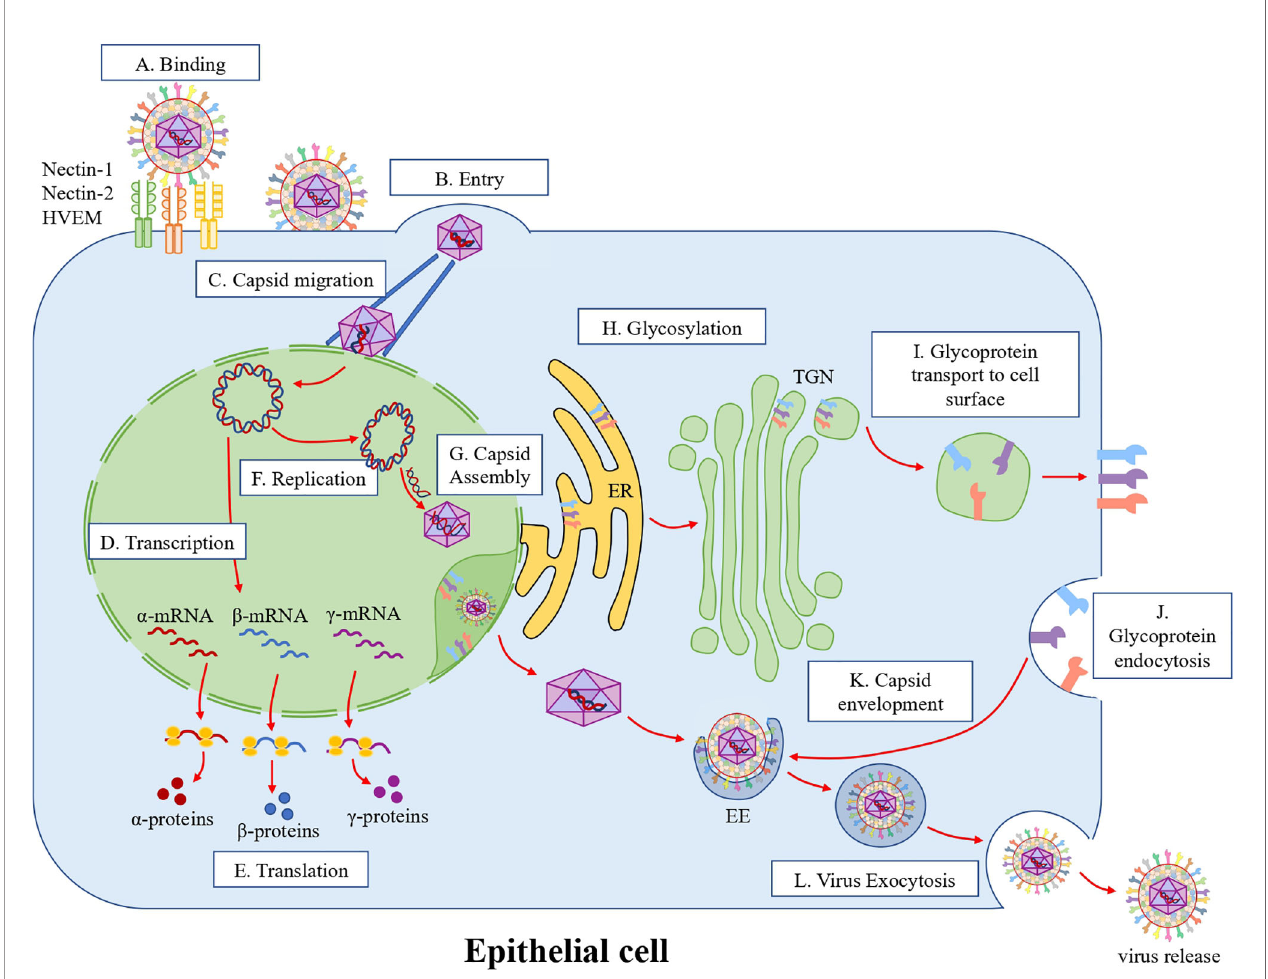
FIGURE 1 | HSV-1 replication cycle in epithelial cells. (A) Attachment and infection. HSV-1 attaches to cell surface receptors. Glycoproteins gB and gC recognize and bind to heparan sulfate proteoglycans (HSPGs) on the cell surface. Then, gD binds to nectin-1, nectin-2 or HVEM, which activates the gH/gL complex on the virion surface, activating in turn gB that acts as a fusion protein combining the viral and cellular membranes. (B) Entry. After the membrane fusion event, the viral capsid and tegument proteins are released into the cytoplasm. (C) Capsid migration. The viral capsids are then transported through microtubules to the outer nuclear membrane, where the viral dsDNA genome is injected into the nucleus through nuclear pores. (D) Transcription. In the nucleus, viral alpha, beta and gamma genes are transcribed sequentially. (E) Translation. Viral mRNAs are then exported from the nucleus to the cytoplasm for their translation and viral protein synthesis. (F) Replication. The HSV-1 genome is circularized in the nucleus and is replicated as a rolling-circle. (G) Capsid assembly. Capsid proteins translocate into the nucleus and assemble the viral capsid in this compartment, where the viral genome is inserted into the capsid. This capsid then crosses the nuclear membrane through envelopment/de-envelopment processes. (H) Glycosylation. Viral glycoproteins are synthesized and initially glycosylated in the rough endoplasmic reticulum (RER). Then, glycoproteins are processed in the trans-Golgi network (TGN). (I) Glycoprotein transport to the cells surface. Then glycoproteins are exported to the cell surface through multivesicular bodies (MVB). (J) Glycoprotein endocytosis. The exported glycoproteins are endocytosed to produce viral particle envelopes in the cytoplasm. (K) Envelopment. Glycoproteins are concentrated in early endosomes (EE) that fuse with the viral capsid in the cytoplasm. (L) Virus exocytosis. Once the capsid is coated with the viral glycoproteins, the virions are released into the extracellular space through